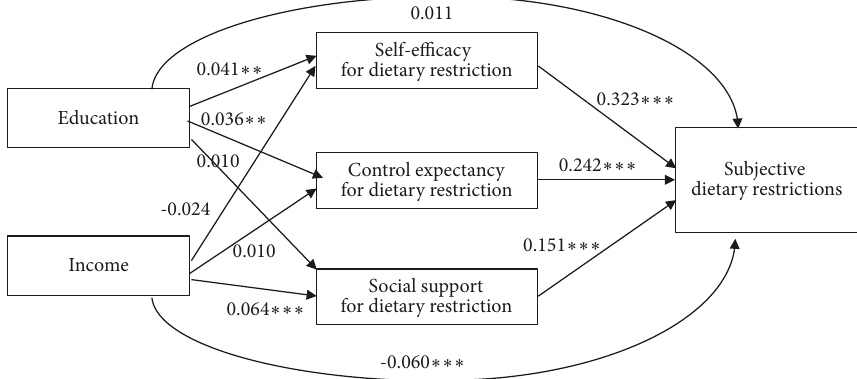
Figure 1: Directand indirecteffectsof socioeconomicstatuson subjectivedietary restrictions as afunctionofpsychosocial mediators.Note 1 : the effects of each variable were obtained after controlling for the influence of other variables without the variable in question. Note 2 : ∗ 𝑃 < .05, ∗∗ 𝑃 < .01, and ∗∗∗ 𝑃 < .001. Note 3 : total indirect influenceof education on subjective dietary restrictions (SDRs) through three mediators